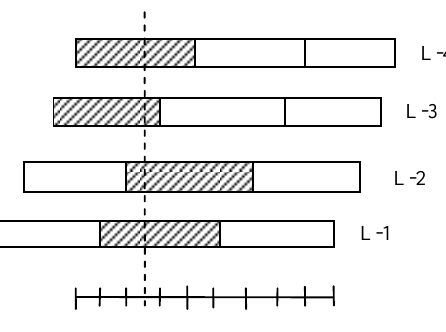
Figure 2. Receptive field